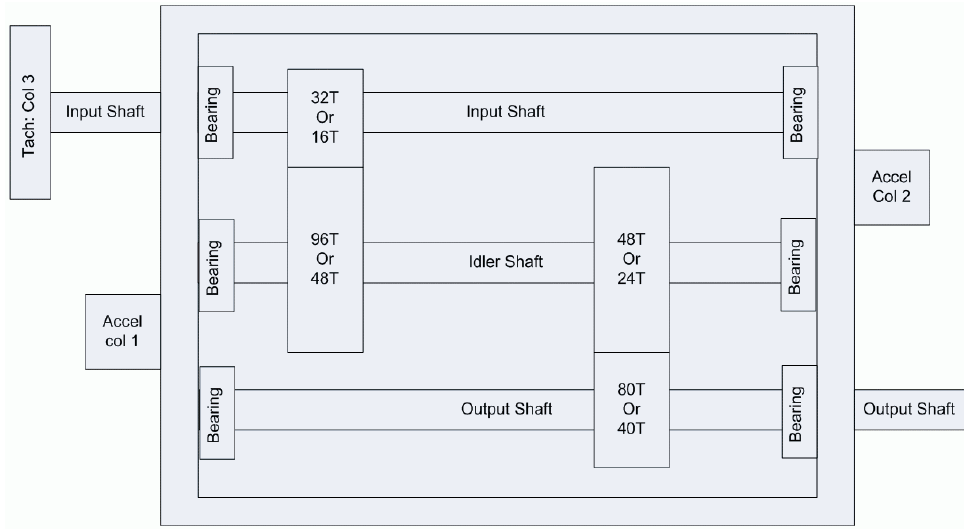
Figure 15. Schematic of the gearbox used in the PHM 2009 Challenge Data [32].